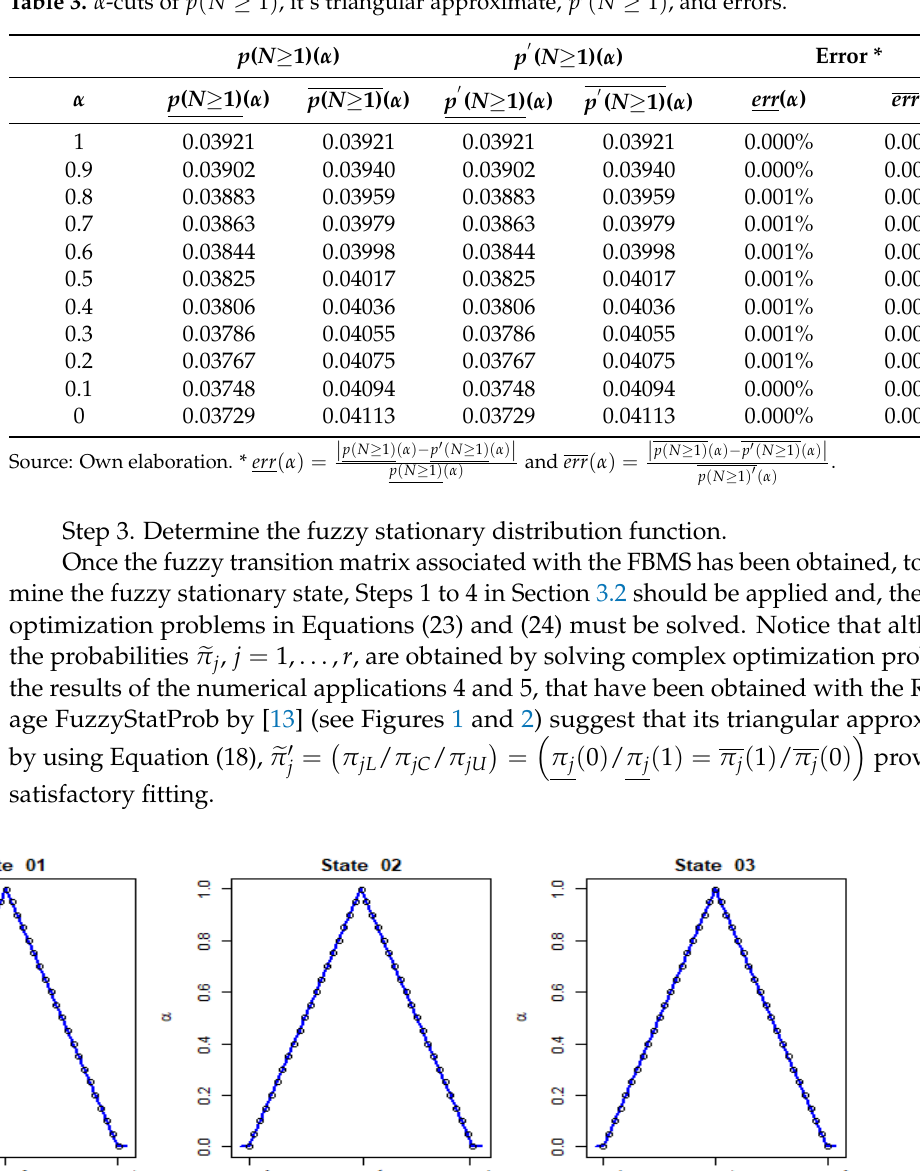
Table 4. Results of the Irish BMS when 𝜆(cid:4634) = (0.038/0.04/0.042) —supports and cores Stationary Probabilities